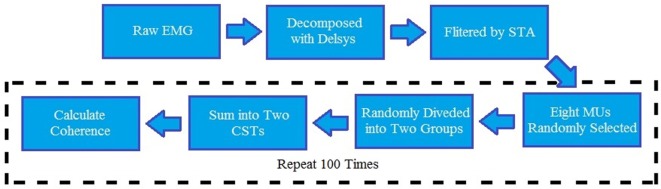
Block diagram for the entire data analysis. EMG, electromyography; STA, spike trigger average algorithm; CST, composite spike train; MU, motor unit.